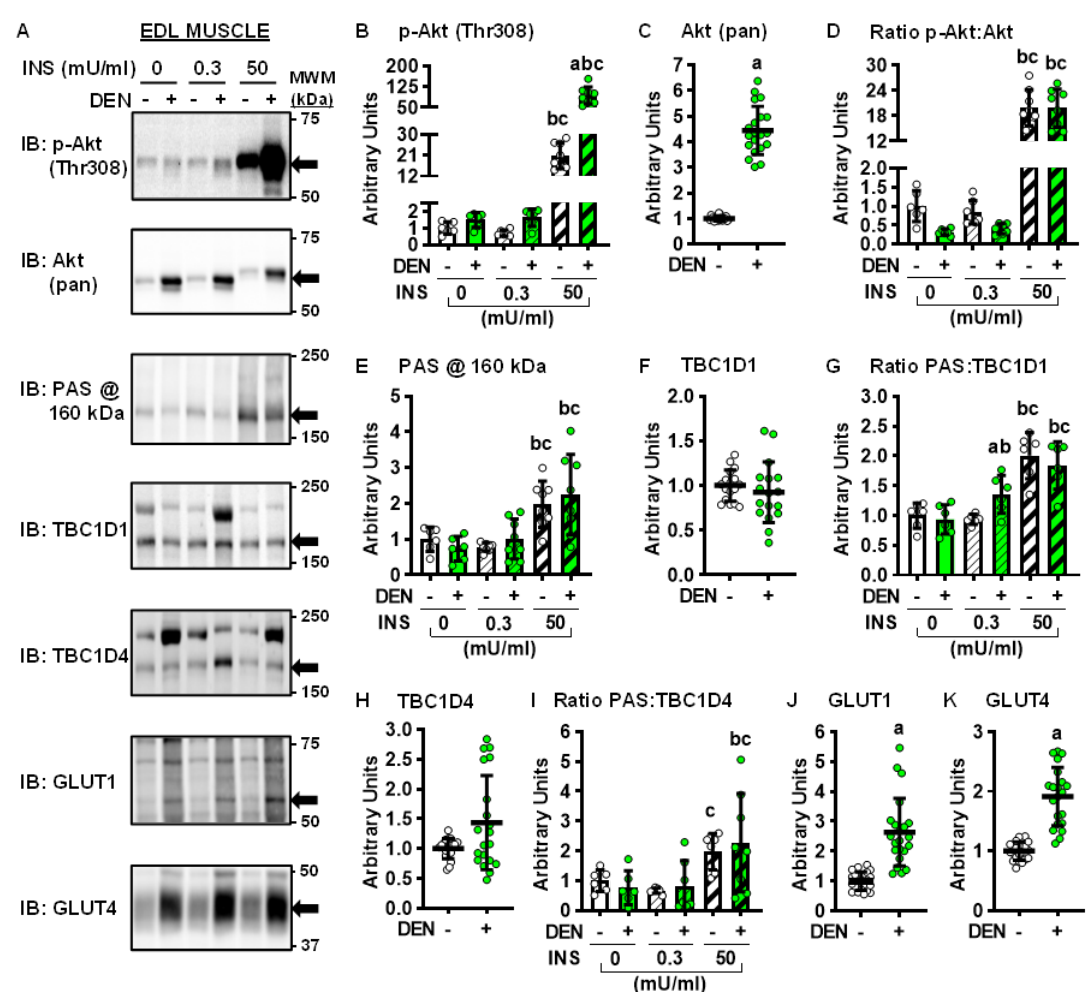
Figure 4. Effects of long-term denervation (DEN) on insulin signaling in the extensor digitorum longus (EDL) muscle. In male wild-type mice, hindlimb muscle DEN was induced in one leg for 28 days while the contralateral leg was sham- operated (-). EDL muscles were excised and incubated in 0, 0.3 or 50 mU/ml insulin (INS). ( A ) Representative immunoblots. ( B – K ) Immunoblot band quantification. Statistical significance was defined as p < 0.05, determined using paired t -tests (for pooled total proteins; panels ( C , F , H , J and K ); n = 17–21 muscles/group), or two-way ANOVAs and Tukey’s post-hoc analysis (panels ( B , D , E , G and I ); n = 6–8 muscles/group), and denoted by ‘a’ vs. -, ‘b’ vs. 0 mU/ml INS, and ‘c’ vs. 0.3 mU/ml INS. GLUT = glucose transporter; PAS = phospho-Akt substrate.